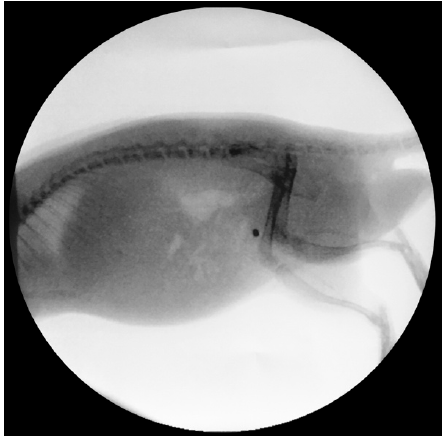
Figure 11. X-ray image of a rat, intravesical implant (2 × 2) mm, Elastollan + barium sulphate + a- C:H/Cu-mulitilayer coating. The selected concentration of 25% barium sulphate in the base material shows sufficient X-ray contrast. X-ray C-arm, Ziehm Vista, Zoom 2, 11 cm, Ziehm Imaging GmbH, Berlin, Germany. After 21 days indwelling time, encrustations were detectable on all the implants from the urinary bladder of the rat (Figure 12).